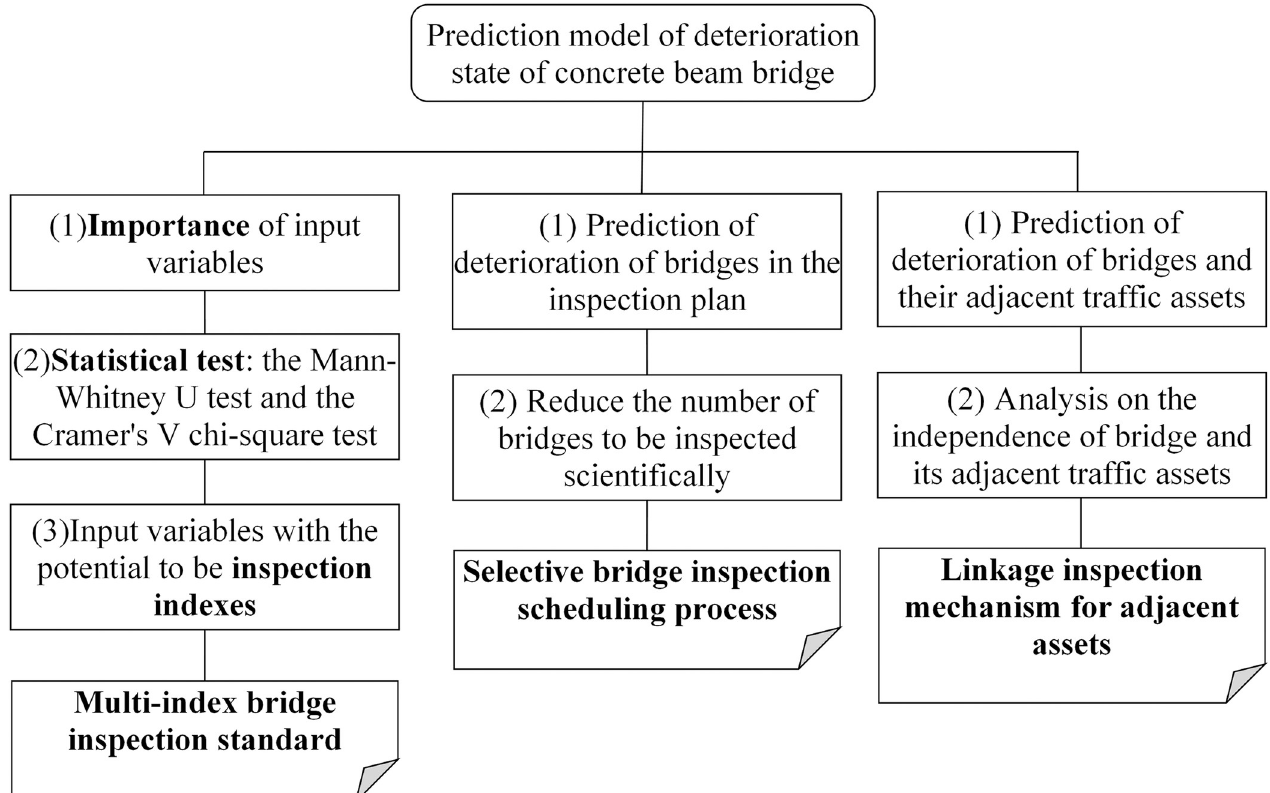
Fig 2. Optimal path of bridge inspection based on prediction of bridge